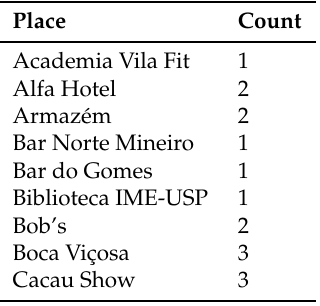
Table 3. Sample of tuples returned by query Q2.